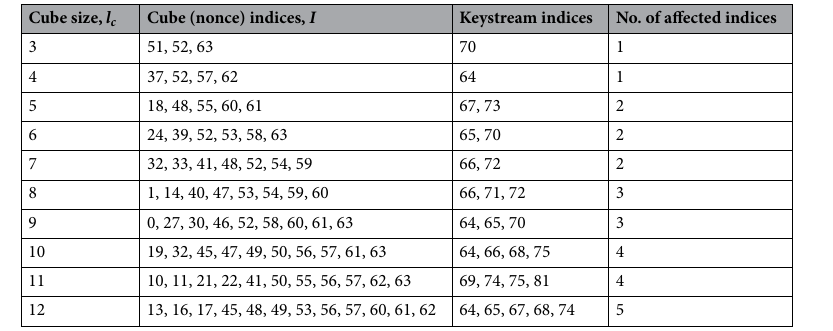
Table 3. Examples of cube testers found using